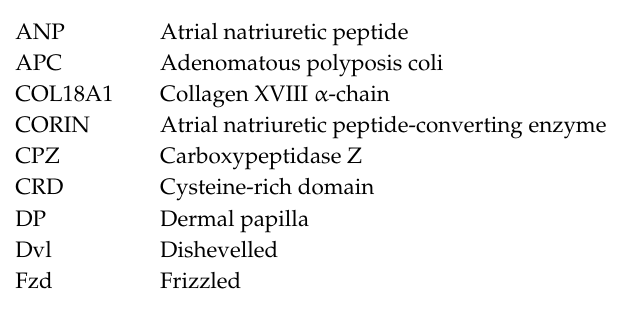
s1. Table S1. Sequences alignments for homology modelling of putative Fzd domains. Table S2. Descriptor values, predicted binding energy and predicted dissociation constants for all Wnt-putative Fzd CRD interactions using the previously published model. Table S3. Descriptor values, predicted binding energy and predicted dissociation constants for all human Wnt-Fzd and Wnt-SFRP interactions with the new model. Table S4. Descriptor values, predicted binding energy and predicted dissociation constants for all Wnt-putative Fzd CRD interactions. Table S5. Aligned sequences of Class F GPCR intracellular loops